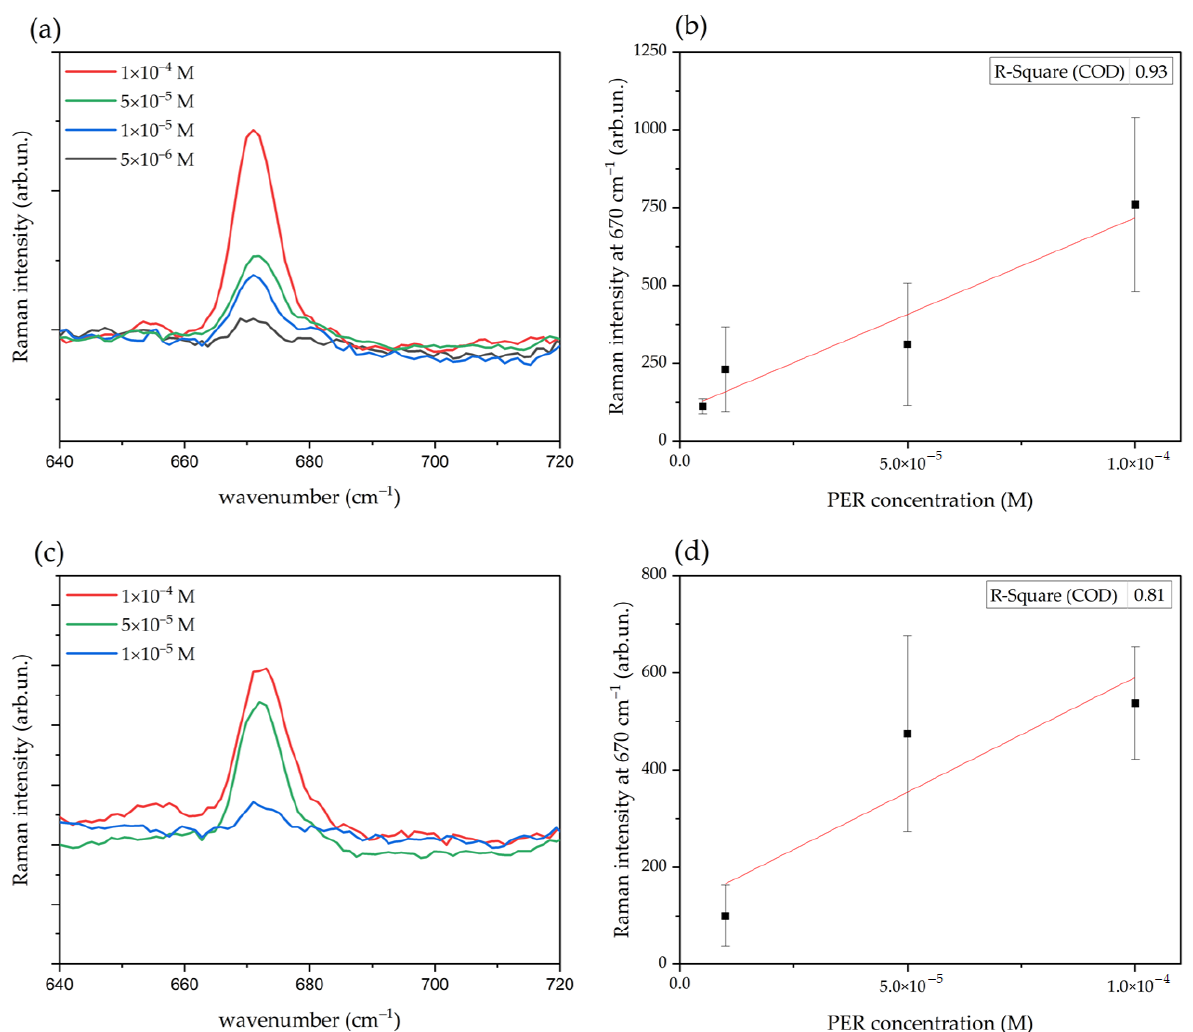
Figure 9. Baseline-corrected average SERS spectra of the 670 cm − 1 marker of PER measured at different concentrations with sensors produced by natural sedimentation ( a ), or by centrifugation ( c ). For each specified concentration, the average spectrum is obtained from five spectra using the corresponding Omnic™ tool [48]. The panels ( b , d ) show the calibration curves corresponding to the SERS data ( a , c ), respectively; the vertical error bars represent the standard